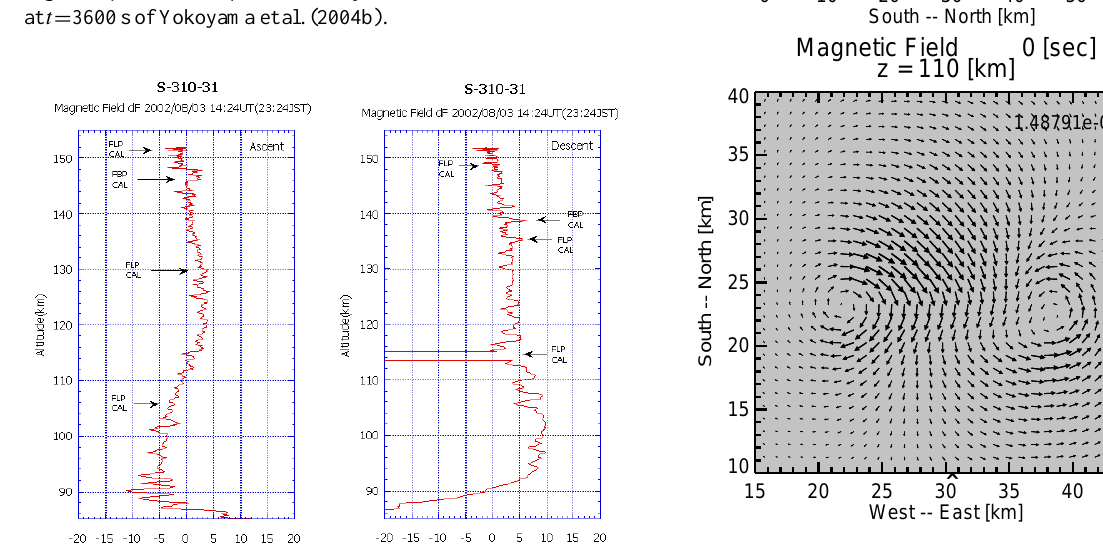
Fig. 9. Magnetic field produced by the current in the case of Fig.